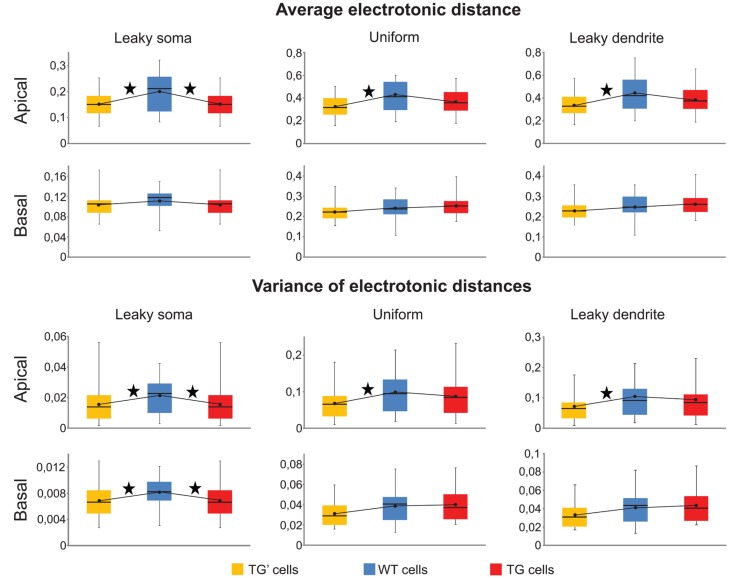
Synaptic input pattern recognition was preserved in uniform and leaky dendrite models of TG neurons. Means and variances of electrotonic distances of synapses in apical and basal dendritic arbors of WT (blue), TG (red), and TG’ (yellow) neurons were computed to compare ability of synaptic input pattern recognition in leaky soma, uniform and leaky dendrites models of these neurons. Box plots show the maximum, 75, 50, and 25% percentiles, and the minimum values. Black dots represent the mean values of computed electrotonic parameters within a population of neurons. Asterisks, above lines, interconnecting black dots, mark signifficant differences in these mean values (Mann–Whitney test, p < 0.05), and predict dissimilar synaptic input pattern recognition capacity in the respective neuron populations.